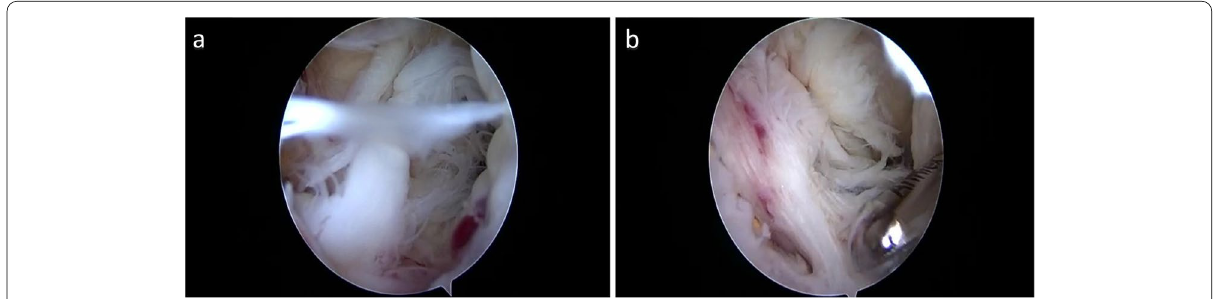
Fig. 2 a - b Intraoperative arthroscopic pictures showing arthrofibrosis in the anterior